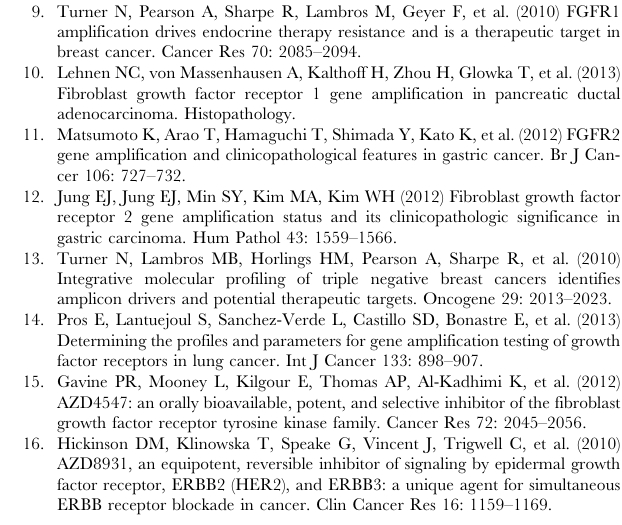
Table S1 FGFR gene amplification: characteristics of included studies. FGFR1 : fibroblast growth factor receptor 1; FGFR2 : fibroblast growth factor receptor 2; NSCLC: non-small- cell lung cancer; SQLC: squamous cell lung cancer; OTSCC: oral tongue squamous cell carcinoma; FISH: fluorescence in situ hybridization; CISH: chromogenic in situ hybridization; SISH: silver in situ hybridization; qPCR: quantitative polymerase chain reaction; aCGH: assay comparative genomic hybridization; SNP: single-nucleotide polymorphism; N/A: not applicable. Table S2 Overall and subgroup analysis of FGFR gene amplification prevalence. FGFR1 : fibroblast growth factor receptor 1; FGFR2 : fibroblast growth factor receptor 2; NSCLC: non-small-cell lung cancer; SQLC: squamous cell lung cancer; OSCC: oral squamous cell carcinoma; OTSCC: oral tongue squamous cell carcinoma; FISH: fluorescence in situ hybridiza- tion; CISH: chromogenic in situ hybridization; SISH: silver in situ hybridization; PCR: polymerase chain reaction; aCGH: assay comparative genomic hybridization; SNP: single-nucleotide poly- morphism; N/A: not applicable; PDAC: Pancreatic ductal adenocarcinoma.